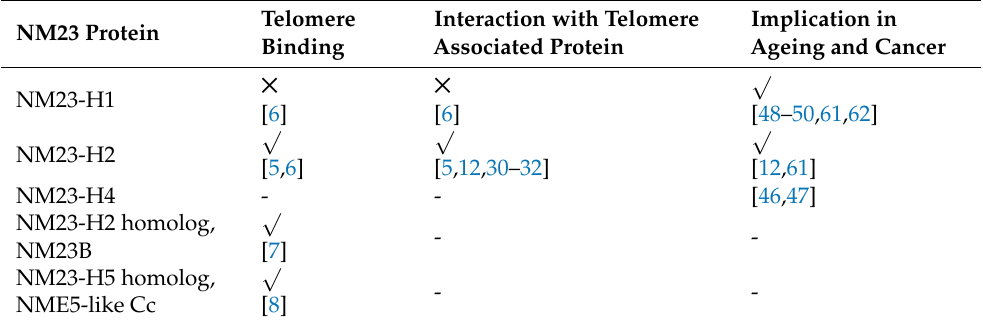
Table 1. Summary of telomere-associated and ageing-related observations of NM23/NDPK